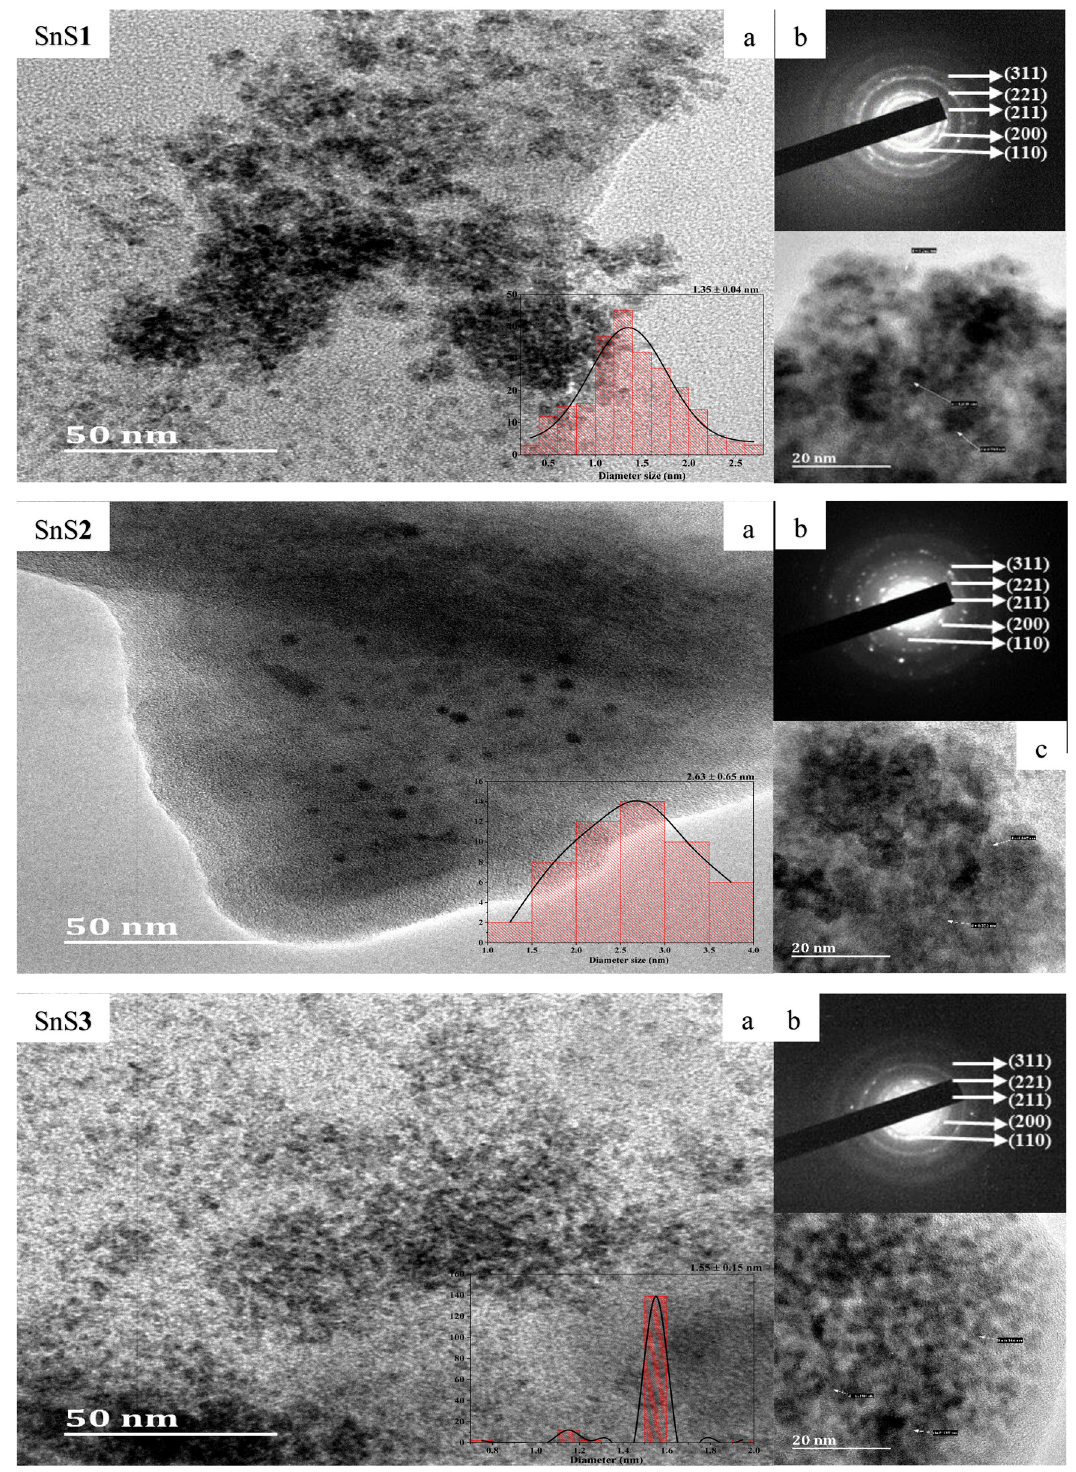
Figure 2: HRTEM images: ( a ) SAED patterns; ( b ) lattice fringes; ( c ) corresponding size distribution graph ( insert ) of SnS